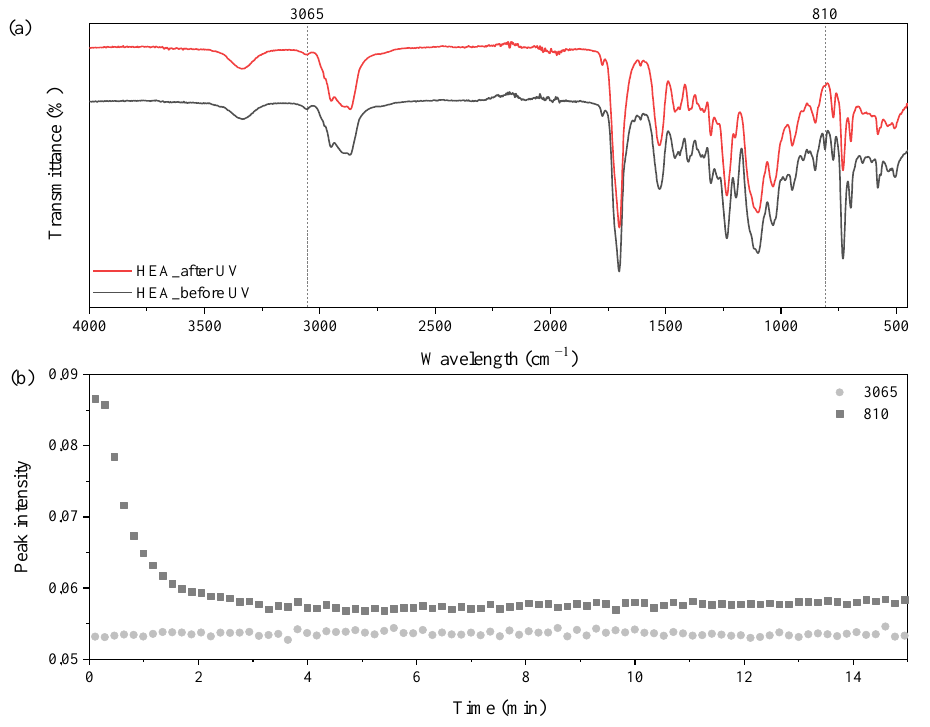
Figure 5. FTIR spectra of UA-DA(HEA) resin ( a ) before and after UV irradiation; ( b ) selected peaks’ intensity during UV irradiation time.